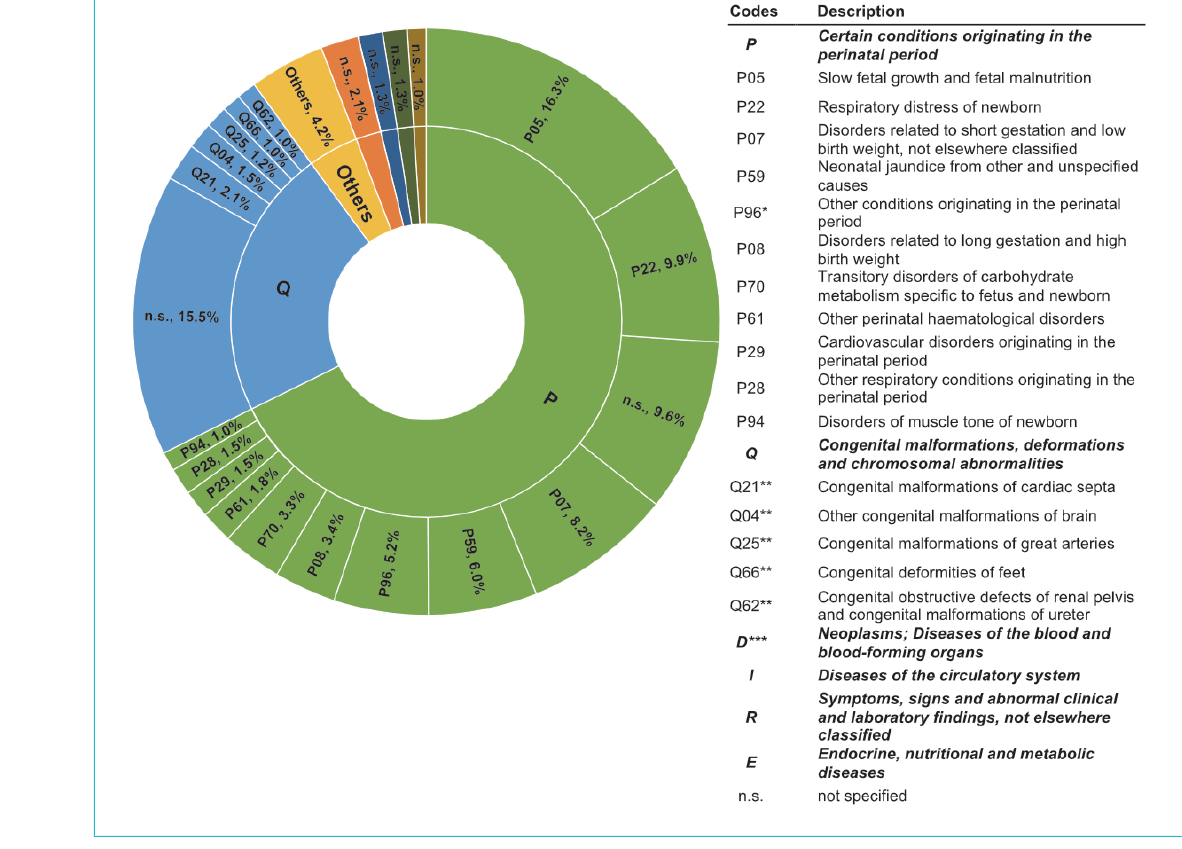
Figure 6: Children’s and obstetric outcomes documented in the follow-up of queries performed during singleton pregnancies upon exposure to medications. Children’s as well as obstetric outcomes (n = 670) are classified according to ICD-10; codes indicating the pregnancy outcome were not considered. The orange, dark blue, dark green and brown sectors are not labelled, due to their small size and correspond to the codes “D”, “I”, “R” and “E”. *without 96.4 **codes for malformations ***The title of sector D is abbreviated and should read “Neoplasms; Dis- eases of the blood and blood-forming organs and certain disorders involving the immune mechanism” in full